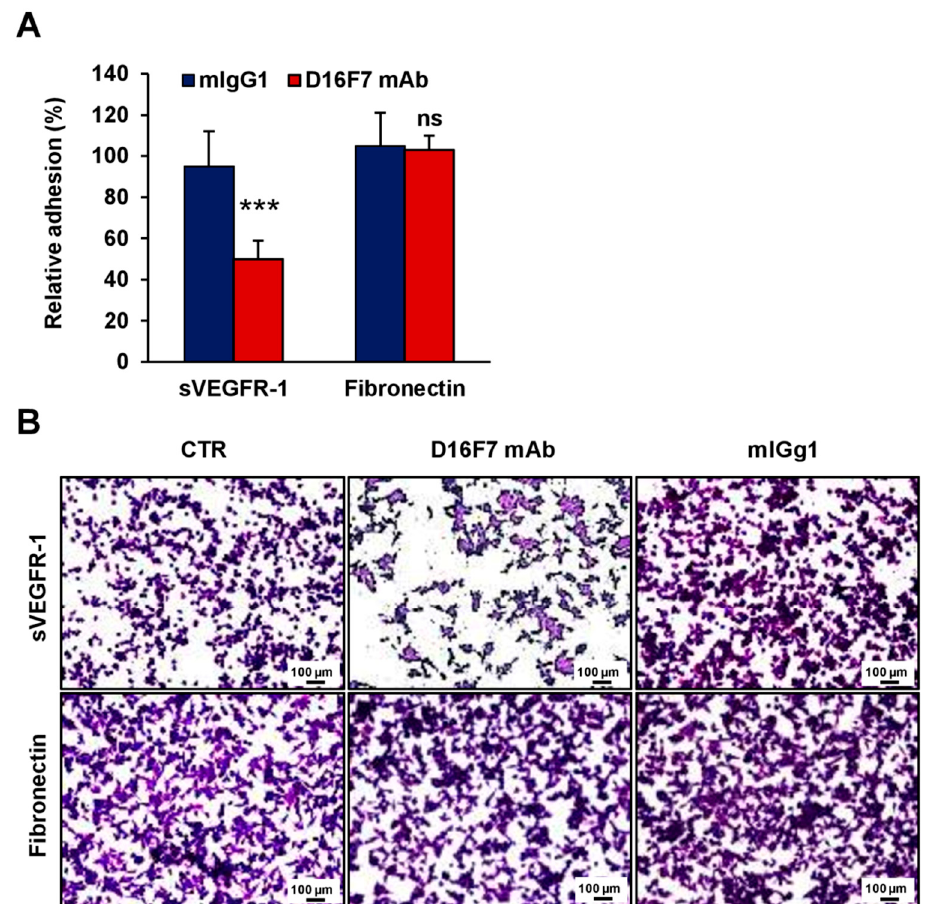
Figure 4. D16F7 mAb inhibits the adhesion of human melanoma cells to sVEGFR-1. ( A ) Adhesion of human melanoma WM266-4 cells was evaluated in 96-well plates coated with recombinant human sVEGFR-1 or with fibronectin as a control for antibody specificity. BSA was used to determine non-specific adhesion. Cell adhesion to sVEGFR-1 and fibronectin was evaluated in the absence or presence of 5 µ g/mL D16F7 mAb or mouse IgG (mIgG1) after 1 h incubation. Each value represents the mean ± SD of 12 (sVEGFR-1) or 10 (fibronectin) total determinations from four independent experiments. Adhesion of melanoma cells to sVEGFR-1- or fibronectin-coated wells, after subtraction of background values (nonspecific adhesion to BSA-coated wells), was expressed as percent adhesion compared to cells incubated in the absence of any antibody. Statistical analysis (normal distribution) was performed by Student’s t -test, comparing adhesion of D16F7 mAb with mIgG1-treated groups to the sVEGFR ‐ 1 substrate: ***, p < 0.001. For adhesion to fibronectin, differences between the D16F7 mAb ‐ and mIgG1 ‐ treated groups were not statistically significant (ns). ( B ) Representative photographs are shown for each experimental condition (100× magnification). The scale bars represent 100 μ m. CTR, control (i.e., untreated cells).